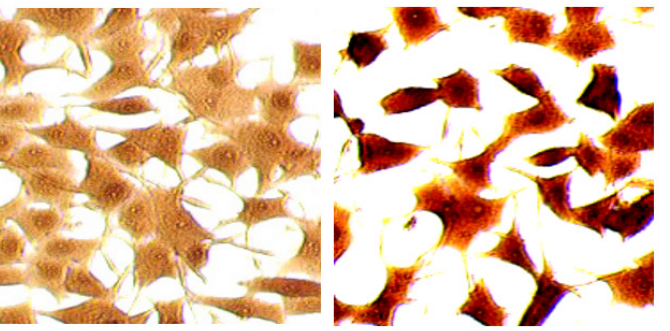
Figure 4. Crocin treatment in PC-12 neurons and immunostaining using an anti-crocin monoclonal antibody (author’s unpublished data). The left panel shows a non-treated control. The right panel shows staining after crocin treatment for 1 h. The black color indicates the cells stained with anti- crocin monoclonal antibodies.